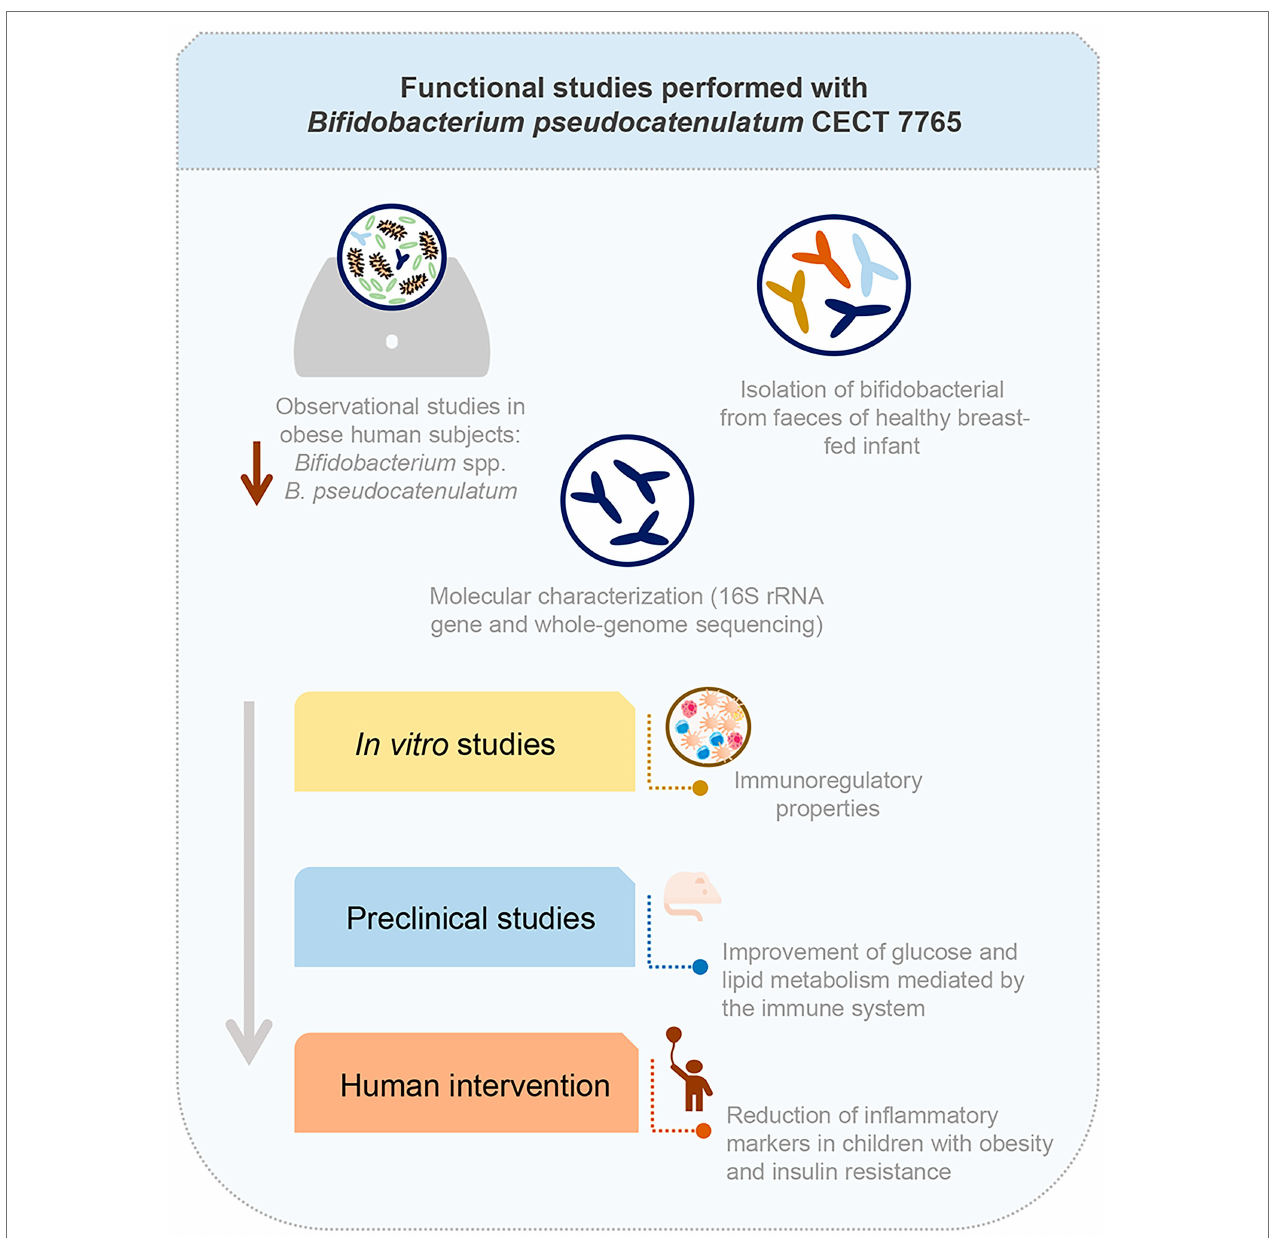
FIGURE 6 | Schematic representation of the process followed to identify and assess the probiotic potential of Bifidobacterium pseudocatenulatum CECT